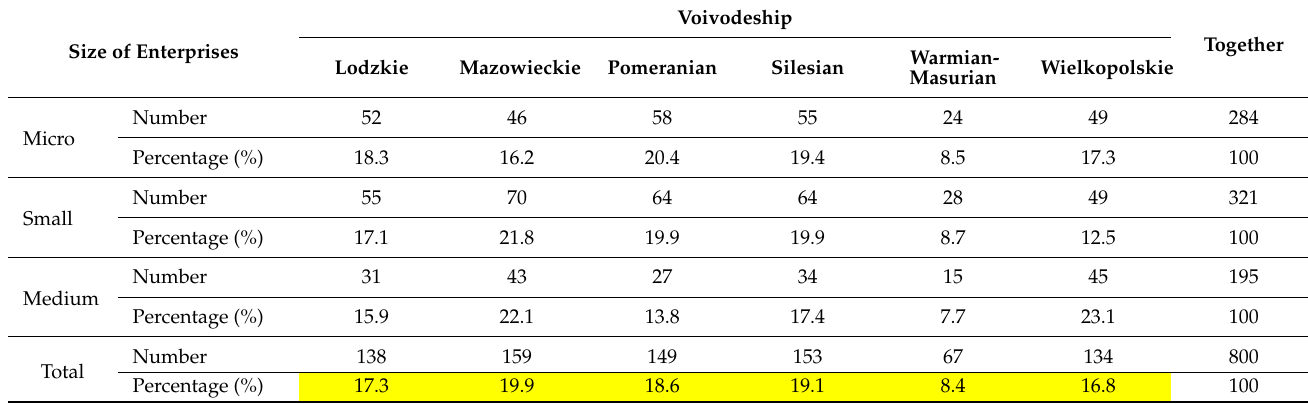
Table 1. Division of the study sample by spatial distribution.